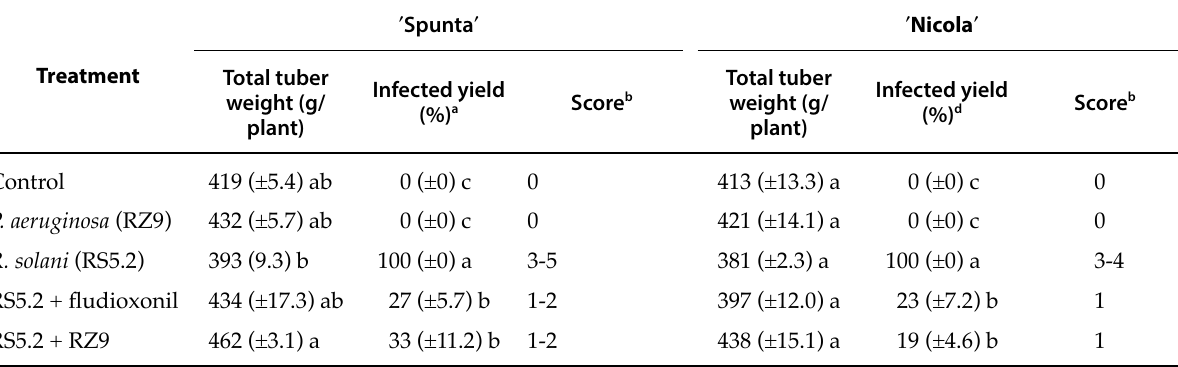
Table 2. Mean of total tuber weights and weights of infected tubers of potato cultivars Spunta and Nicola in biocontrol assays against Rhizoctonia solani with the strain RZ9 of Pseudomonas aeruginosa under greenhouse conditions. The assays involved the application of R. solani strain RS5.2, the strain RZ9 of P. aeruginosa , and the fungicide fludioxonil, separately or in